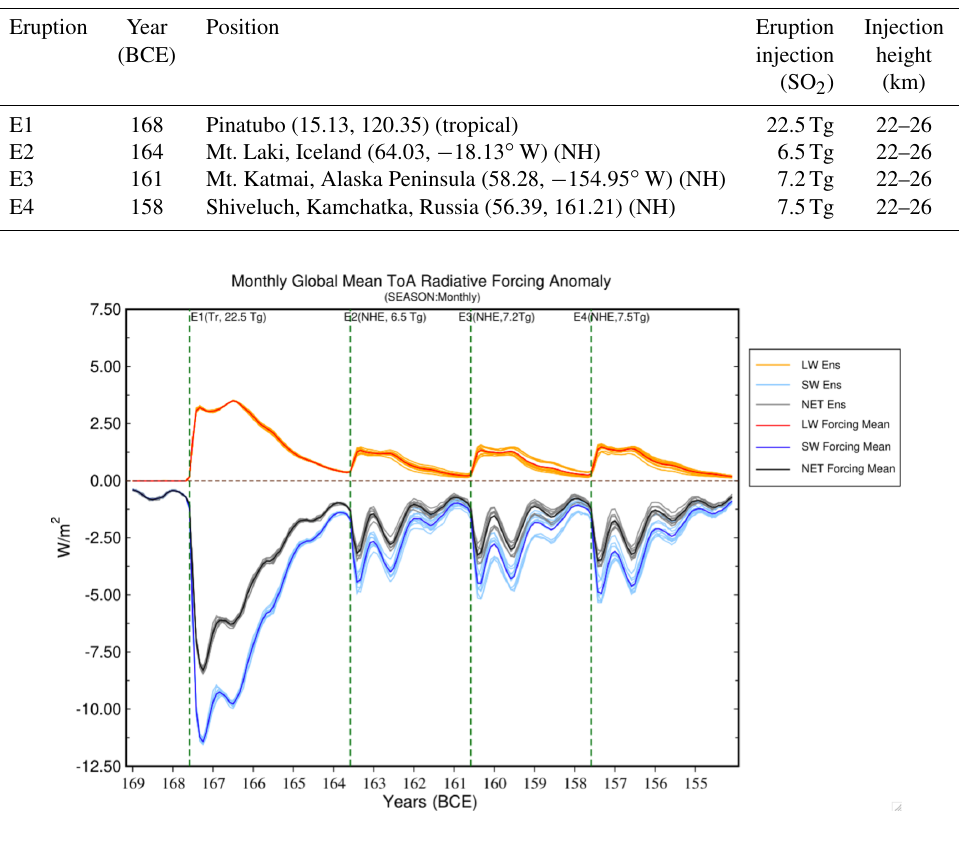
Figure 4. Monthly mean top of the atmosphere radiative balance perturbation due to volcanic aerosols for the entire simulation length. Or- ange/red shows the longwave radiative response, light/dark blue represents the shortwave, and gray/black represents the net (TOA) radiative change averaged at the global scale. The light-colored solid lines represent individual ensemble members, and the dark-colored lines show the ensemble mean. The green vertical dashed lines show when the eruptions